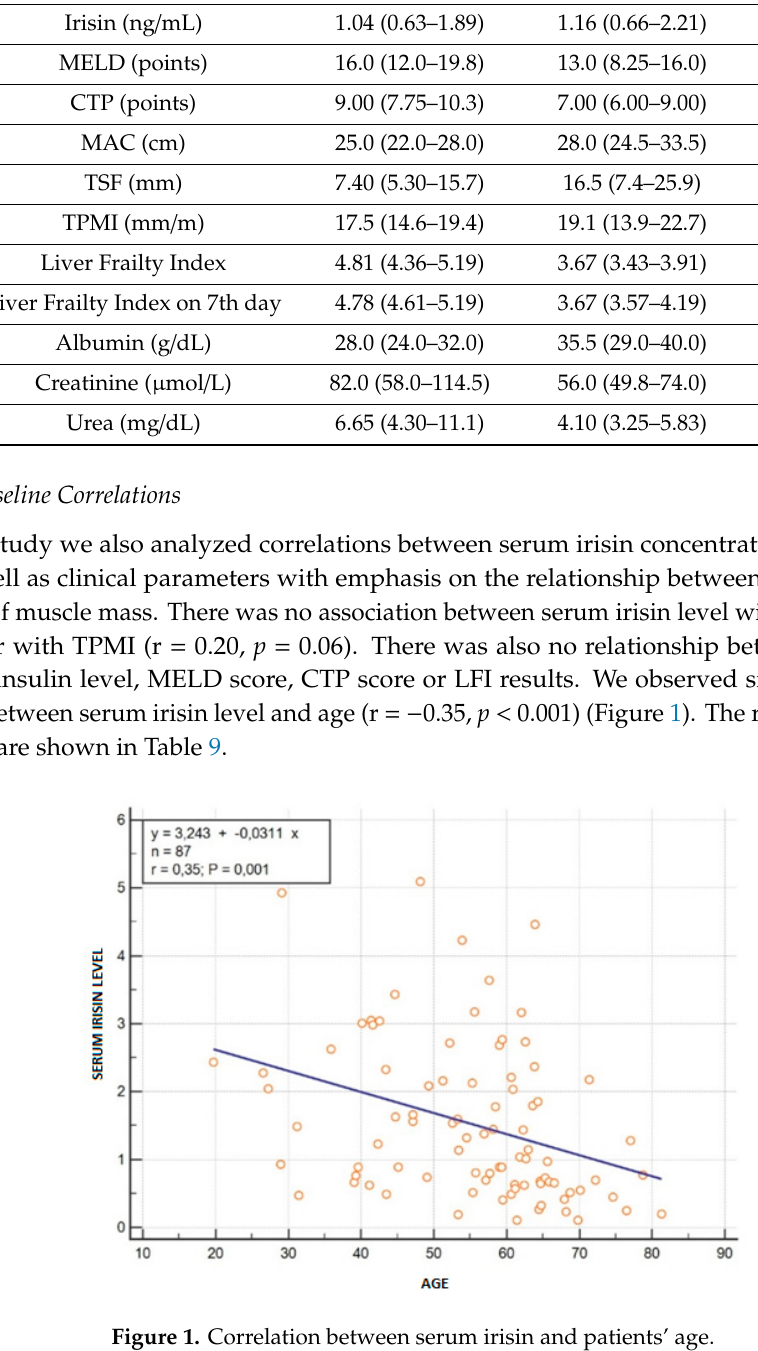
Table 8. Comparison of analyzed parameters between cirrhotic patients with and without sarcopenia according to HGS value.